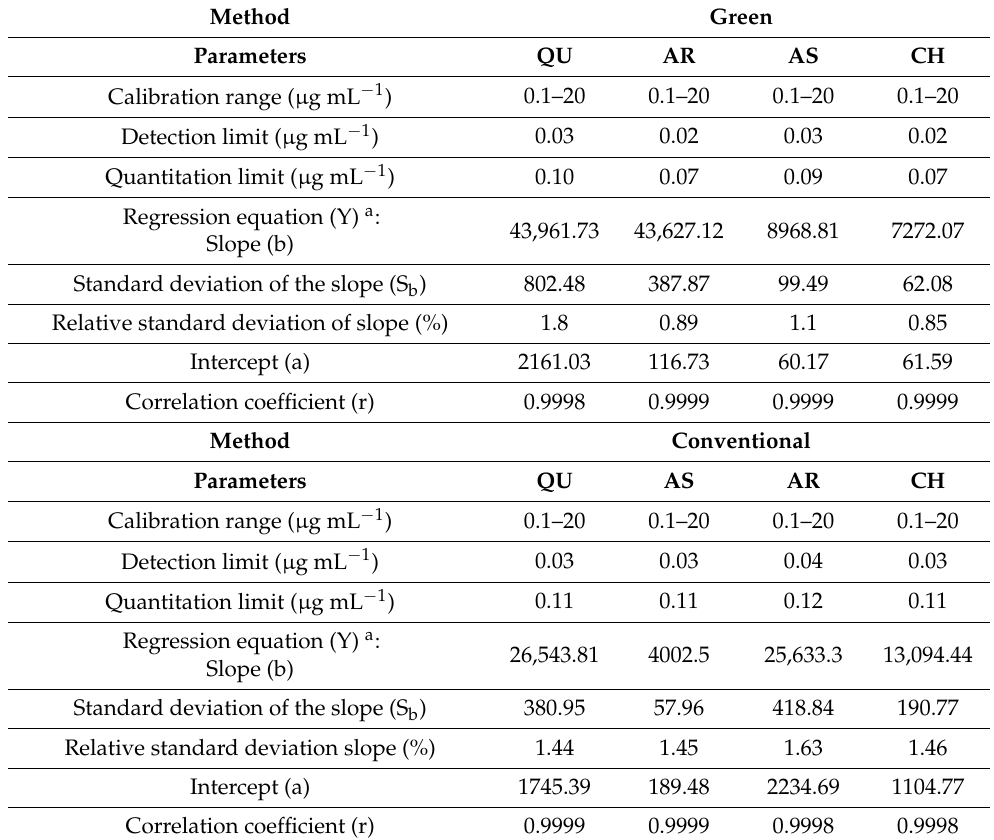
Table 2. Characteristic parameters of the calibration equations for the developed green and conven- tional HPLC methods for analysis of QU, AS, AR, and